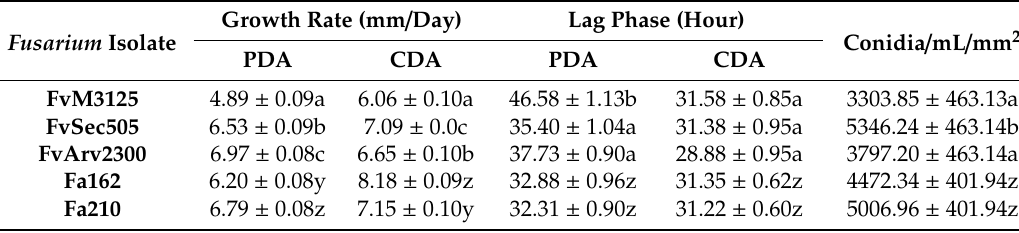
Table 2. Growth rate, lag phase, and conidia production of the mycovirus-infected and mycovirus-free strains.